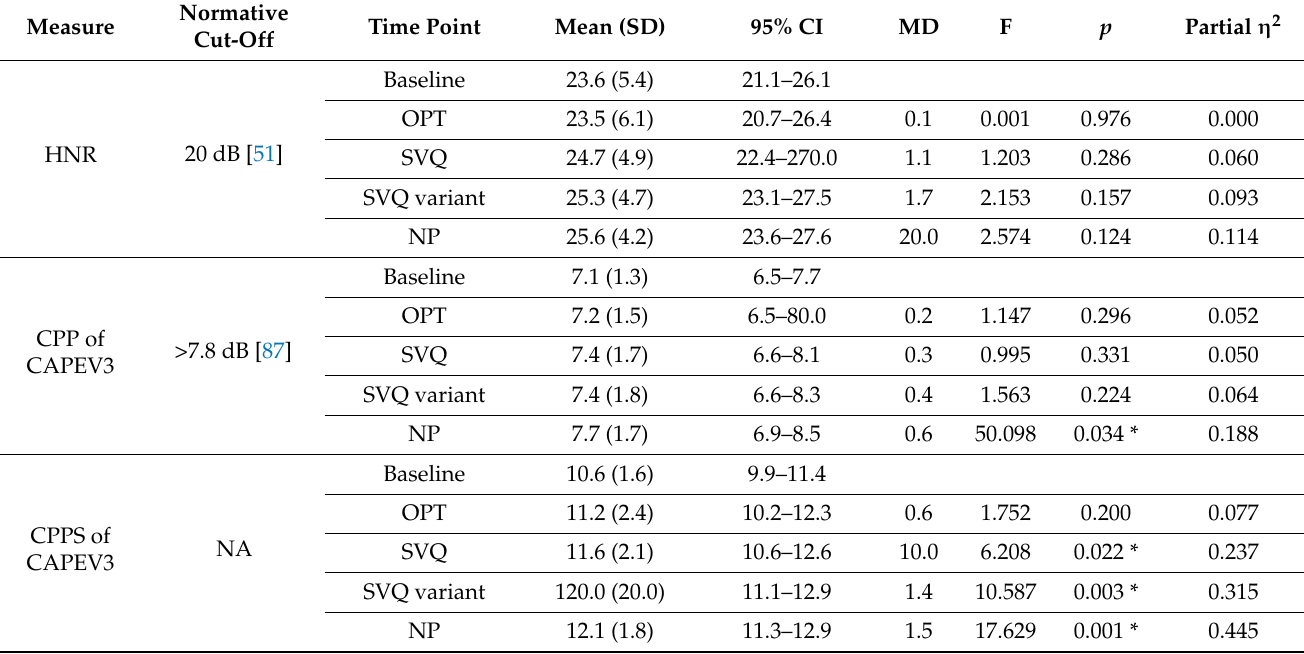
Table 7. Acoustic outcomes after four stages of Sob Voice Therapy. Partial η 2 = 0.01, 0.1, and 0.25 indicate small, medium, and large effects, respectively. Abbreviations: MD, mean difference and NA, not available; (*), significance at p <